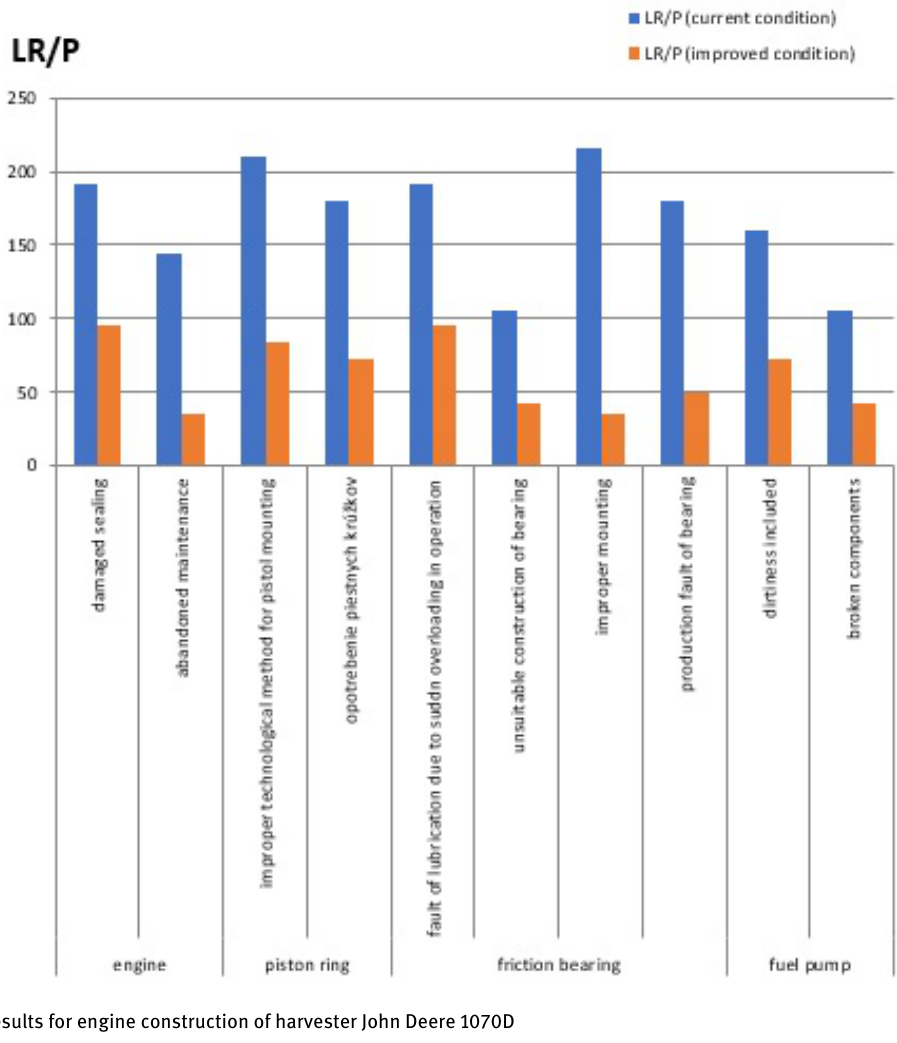
Figure 3: FMEA results for engine construction of harvester John Deere 1070D